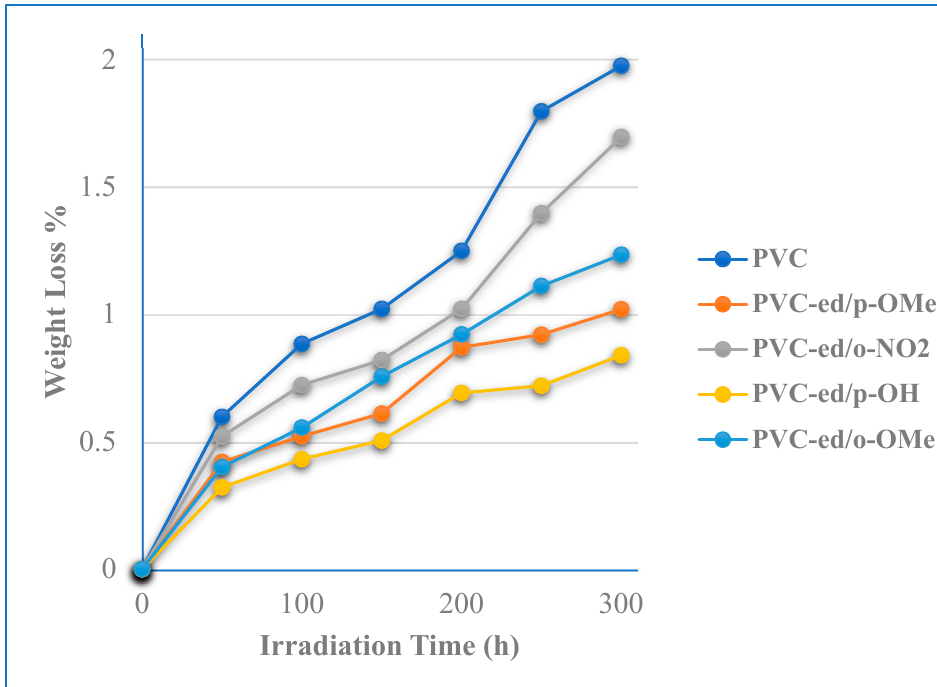
Figure 4. Weight loss percentage versus irradiation time of PVC films.